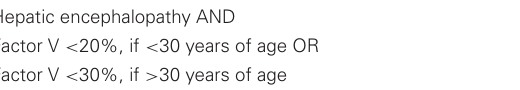
Table 1 | Clichy-Villejuif criteria for non-acetaminophen ALF. Hepatic encephalopathy